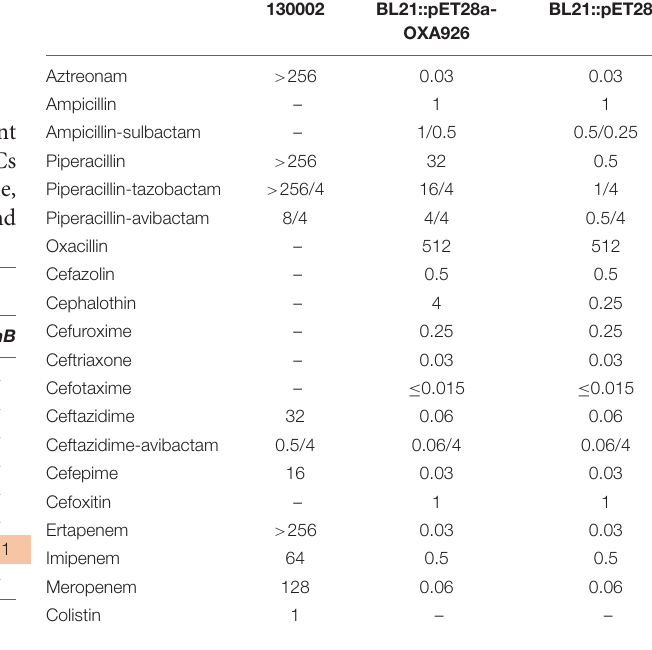
TABLE 2 | MIC (mg/L) of β -lactams for 130002 and E. coli BL21 expressing OXA-926 or